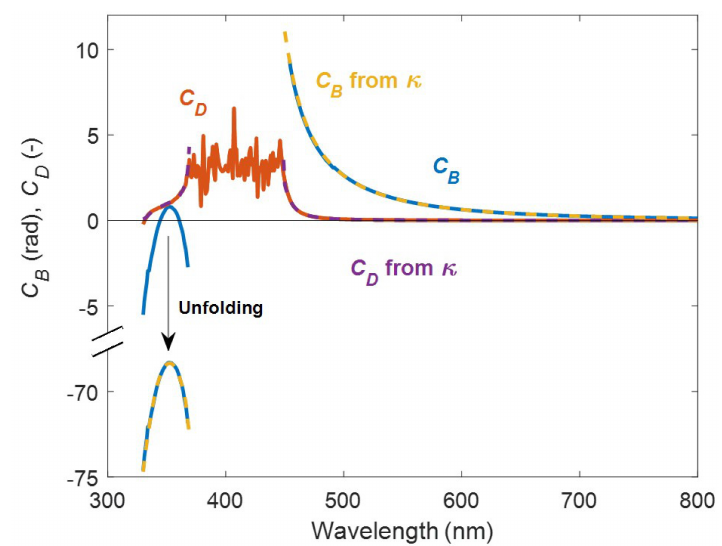
Figure 12. Circular dichroism C D and circular birefringence C B for the ChGLC sample determined by differential decomposition of the MMSE data in Figure 10 (solid curves). An offset adjusted curve (“Unfolding”, see text for details) for C B is also shown. The dashed curves show C B and C D calculated from fitted κ